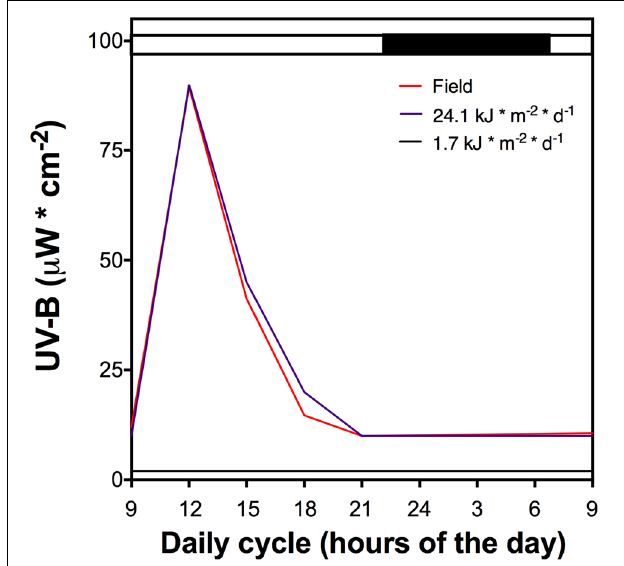
FIGURE 1 | The UV-B light cycle that the cultured D. antarctica plants were exposed, purple line represents 21.4 kJ m − 2 d − 1 dose, black line the control (1.7 kJ m − 2 d − 1 ) and red line UV-B data recorded in field conditions. Light period is indicated by a white bar and darkness by a black bar above the figure. The dark period shows a low UV-B radiation dose.